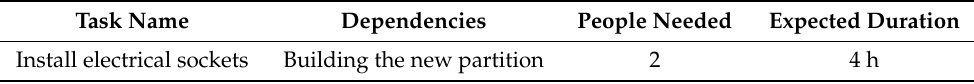
Table 4. Information regarding the installation of a couple of electrical sockets.